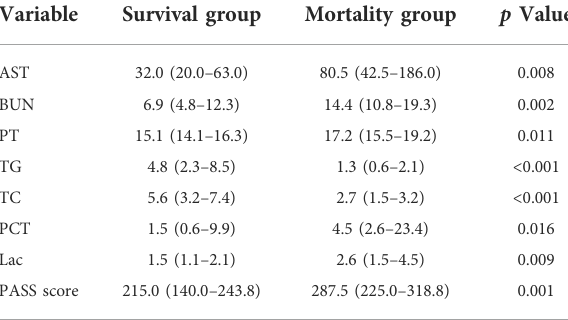
TABLE 5 Univariate analysis of the mortality group and survival group.